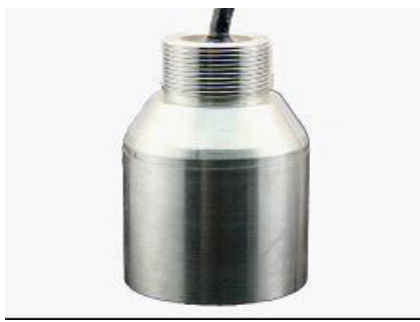
The sonar parameters